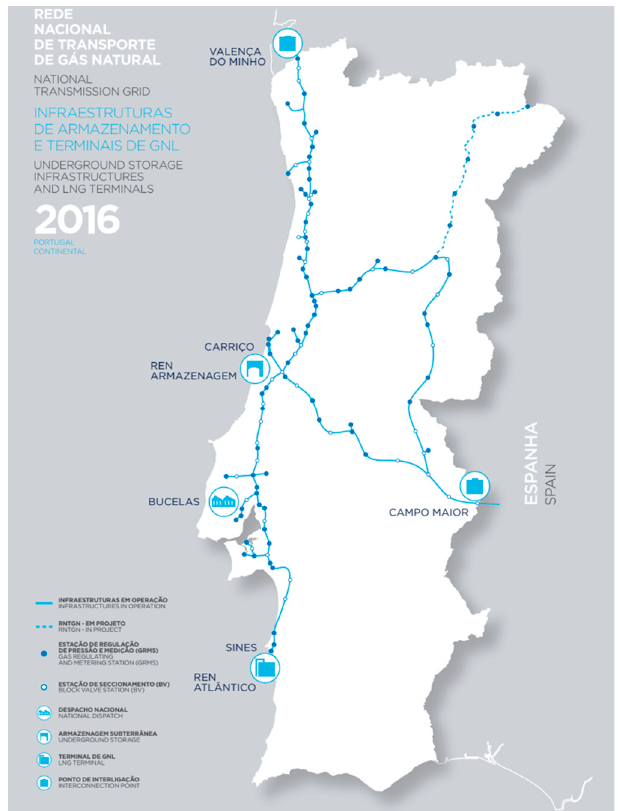
Figure 13. Portugal natural gas storage and transportation infrastructure (reprinted from [36] with permission from REN).